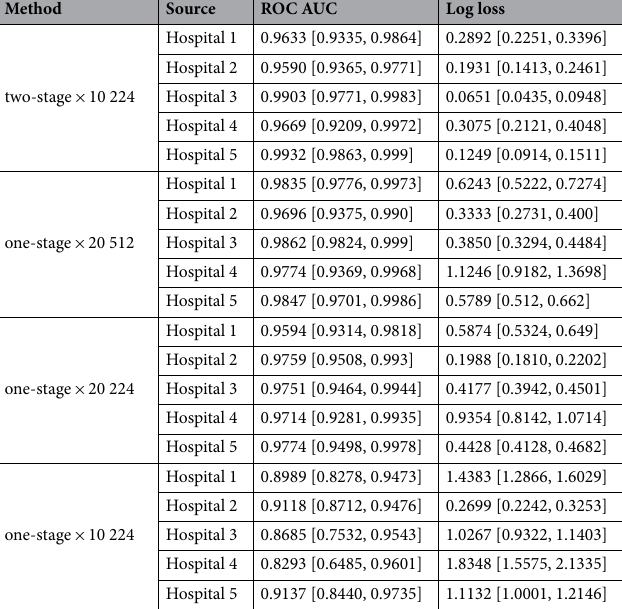
Table 1. ROC AUC and log loss results for the four different models as evaluated on the five different test sets. First row group corresponds to the two-stage model, and the remaining three correspond to the one-stage models, with variations in magnification and tile size. Confidence intervals are between brackets.